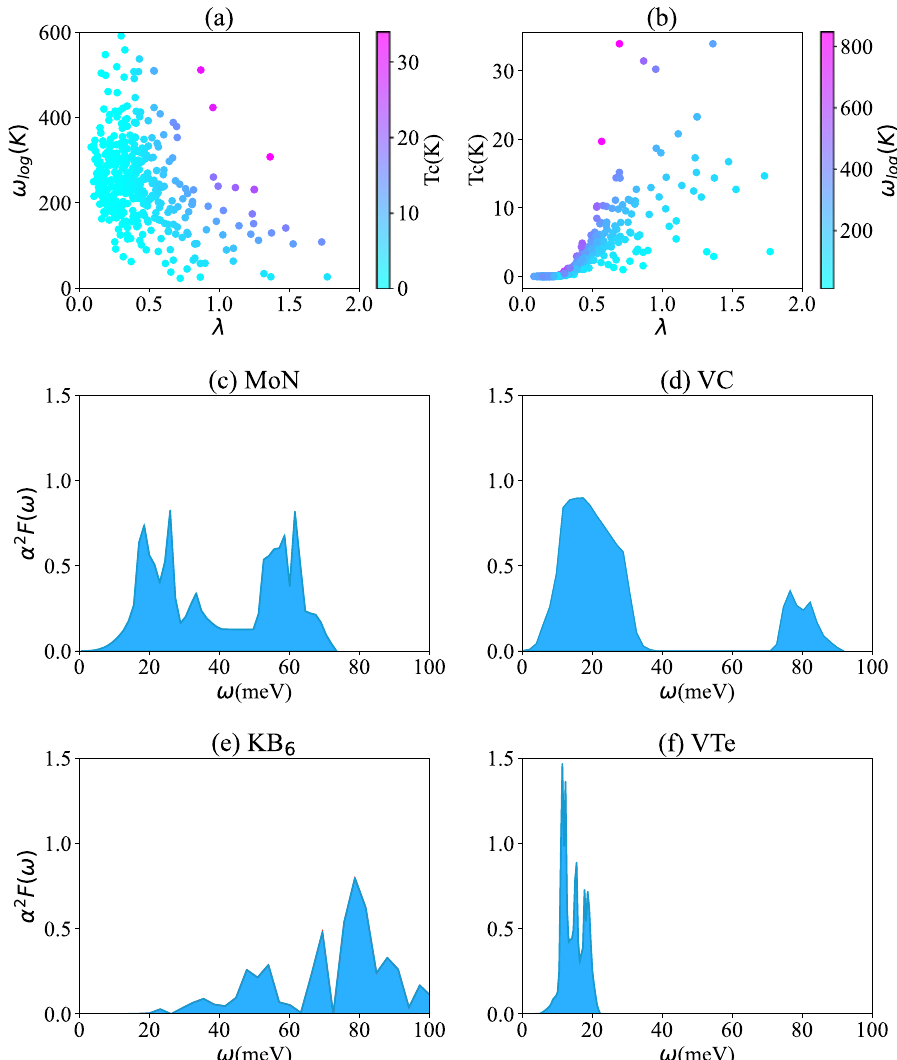
Fig. 5 Relation between electron – phonon coupling parameters and EPC function of some of the potential candidate superconductors. a ω log vs λ , b T C vs λ , c MoN, d VC, e KB 6 , and f